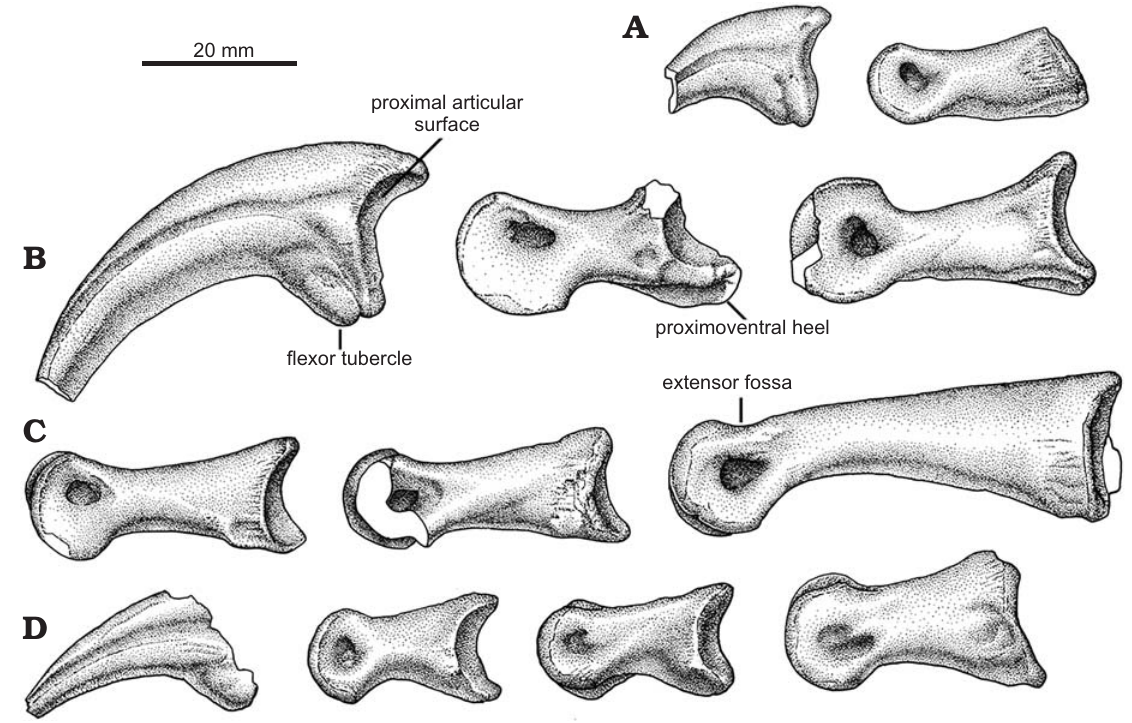
Fig. 10. Unenlagiid theropod Neuquenraptor argentinus Novas and Pol, 2005 (MCF PVPH 77) from Sierra del Portezuelo, Neuquén Province, Argentina; Portezuelo Formation, Coniacian, Late Cretaceous; left pedal phalanges: I ( A ), II ( B ), III ( C ), IV ( D ); in lateral